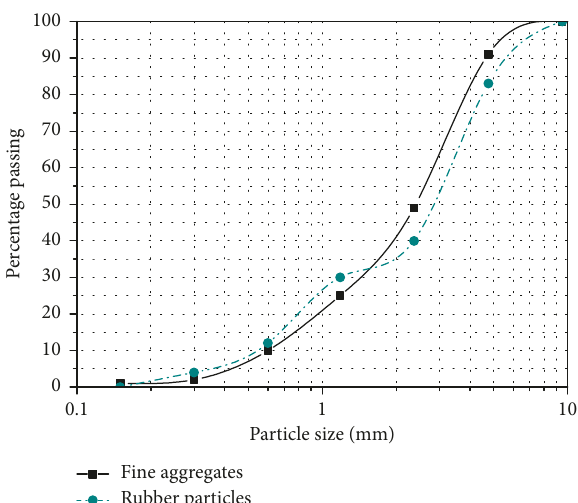
Figure 3: Particles size gradation of fine aggregate and rubber